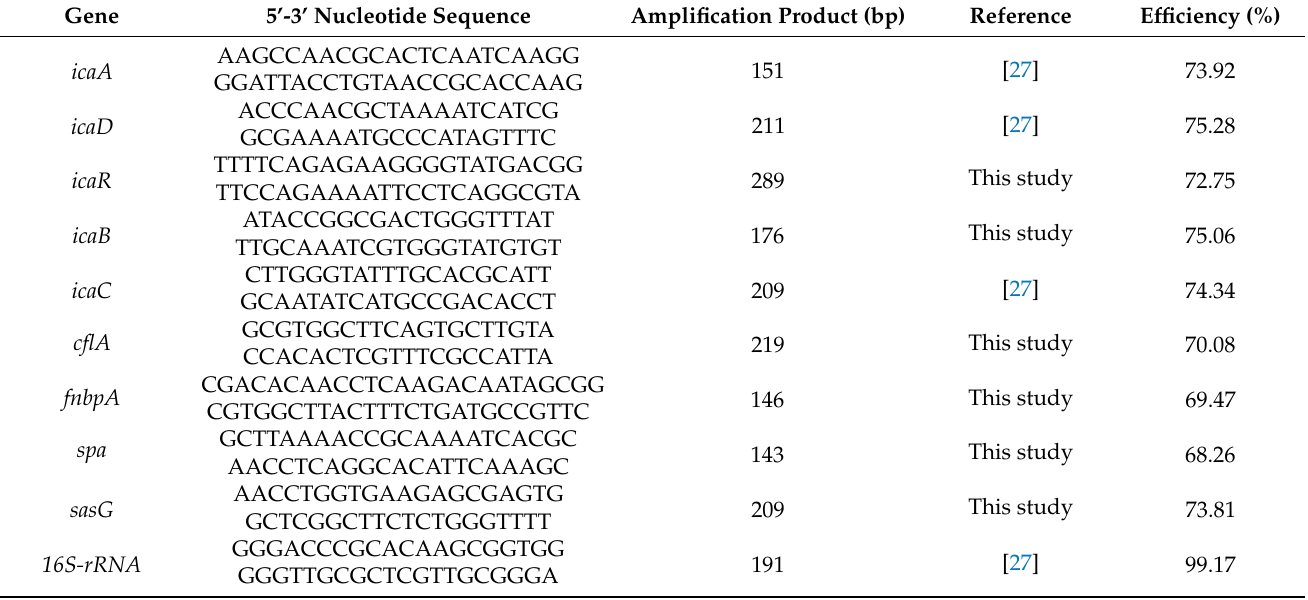
Table 2. Primers used in this